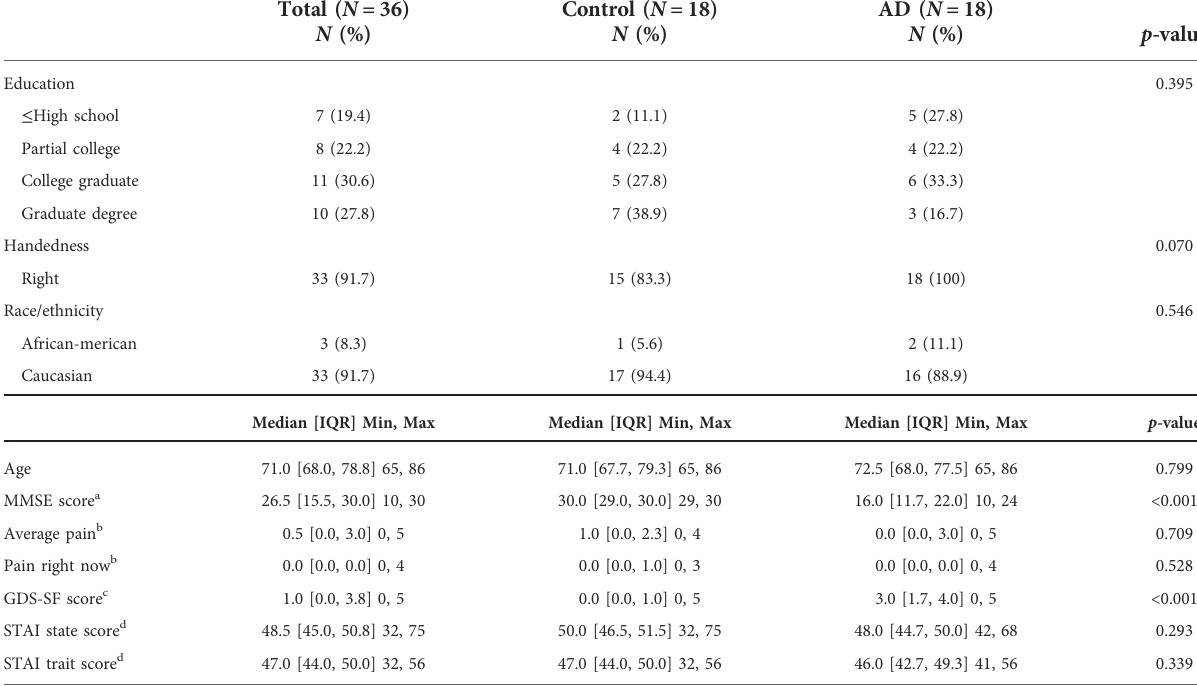
TABLE 1 Demographic and clinical characteristics by study